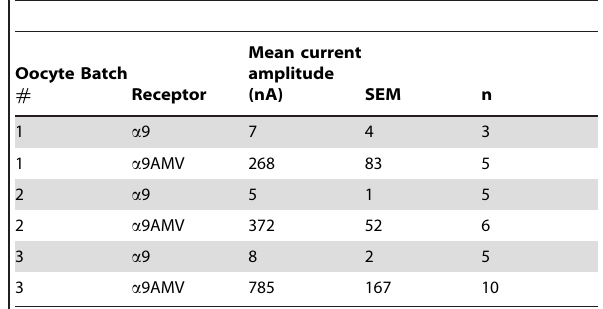
Table 4. AMV improves the expression of human a 9 a 10 heteromeric receptors.